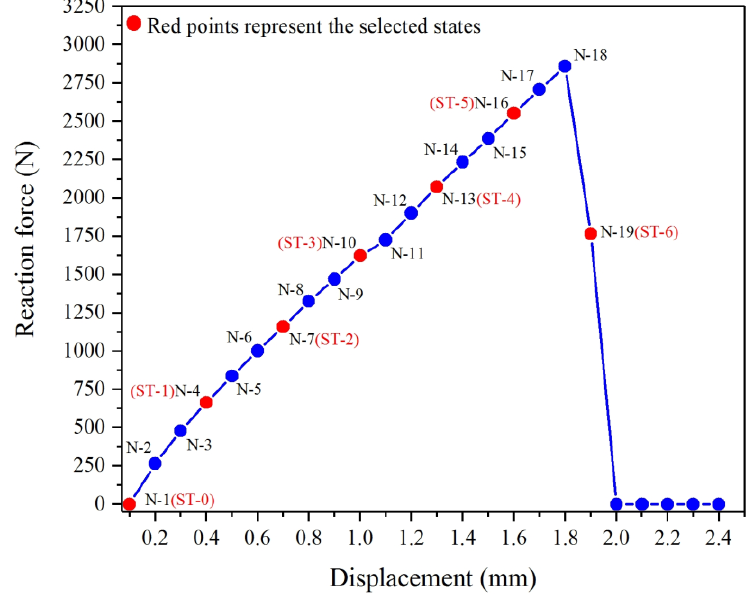
Figure 3. “Displacement vs. reaction force” curve in quasi-static tensile experiment. Table 4. Selected and renamed typical states.